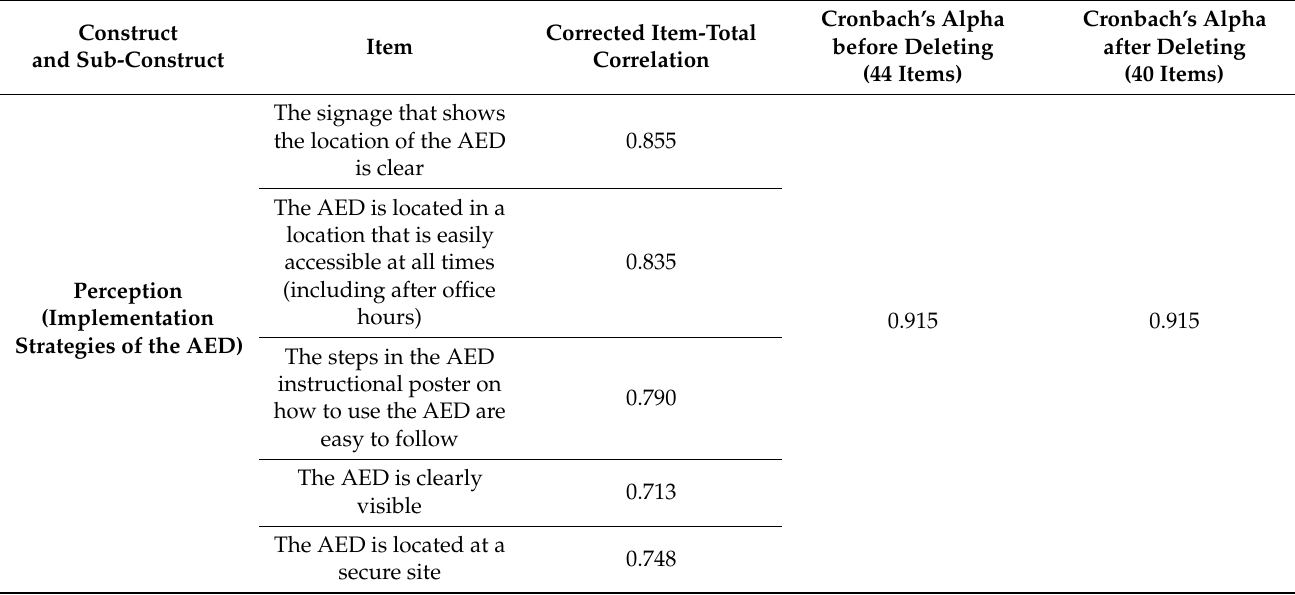
Table 5. Reliability of subscales.